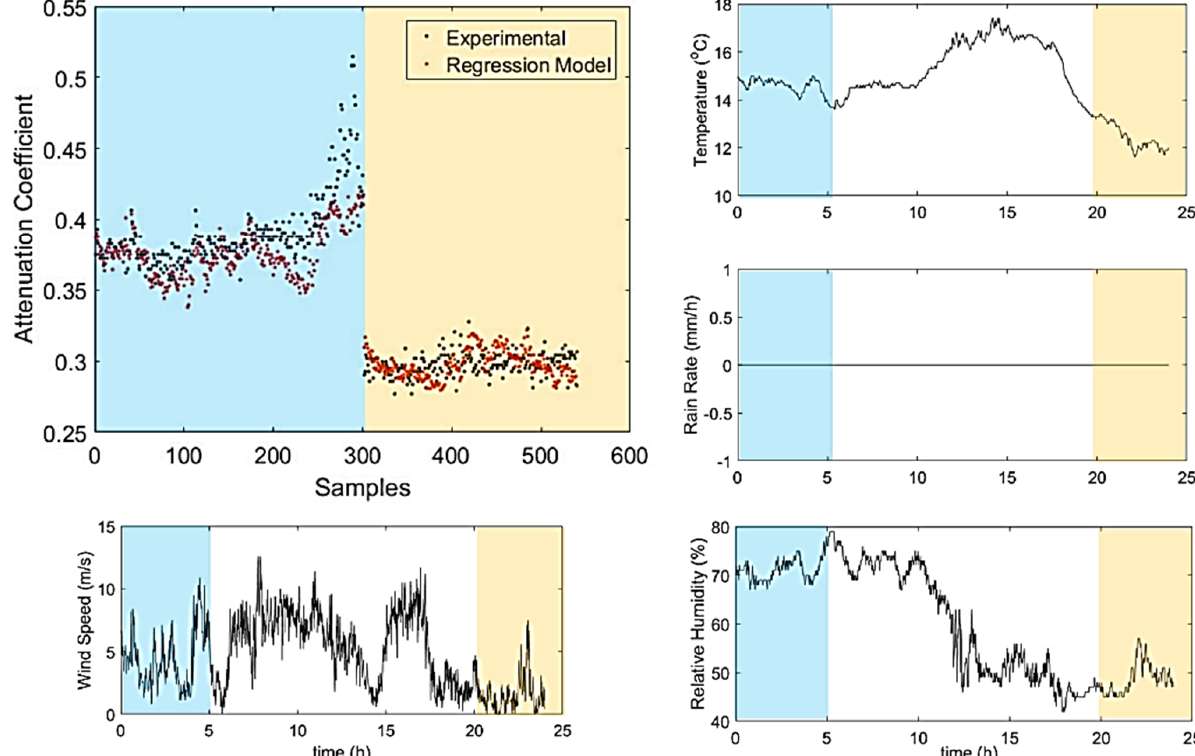
Figure 8. Experimental measurements and model predictions, i.e., Equation (6), for 30 January 2020.